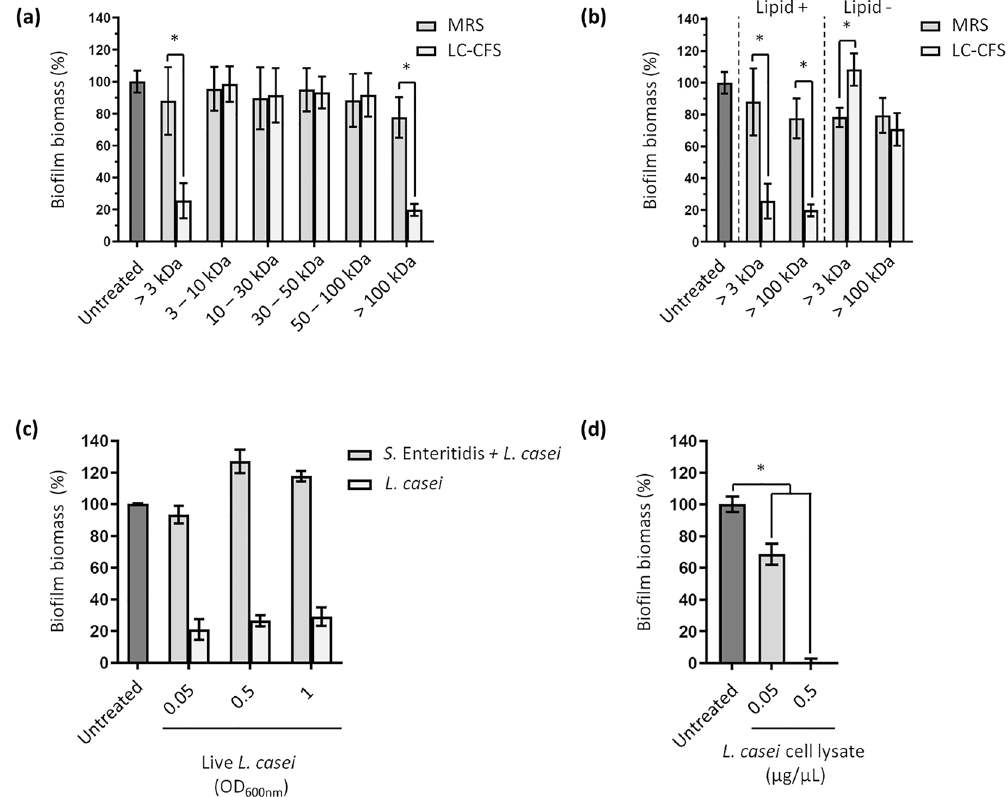
Figure 1. L. casei BL23 releases lipid components of high molecular weight in the supernatant with antibiofilm properties. ( a ) S . Enteritidis was grown in polystyrene microplates and treated with multiple fractions of L. casei cell-free supernatant (LC-CFS) and MRS medium (MRS). After 24 h of culture, the biofilms were quantified by crystal violet staining. The LC-CFS and MRS medium were fractionated by size-exclusion ultrafiltration, generating fractions with molecular weight ranging from 3 kDa to over 100 kDa. ( b ) The LC-CFS fractions exhibiting an antibiofilm activity and the corresponding MRS fractions were treated with a lipid adsorption matrix to selectively remove all the lipids. Biofilm biomasses of S . Enteritidis were then quantified by crystal violet staining after treatment with the fractions in the absence (Lipid −) and in the presence (Lipid +) of lipids. ( c ) S . Enteritidis biofilm formation was quantified after treatment with live L. casei . Please note that the control condition “ L. casei” shows the biomass formed by L. casei BL23 in TSB without S . Enteritidis. ( d ) S . Enteritidis biofilm formation was quantified after treatment with lysed L. casei . All the results were normalized to the untreated conditions and expressed as a